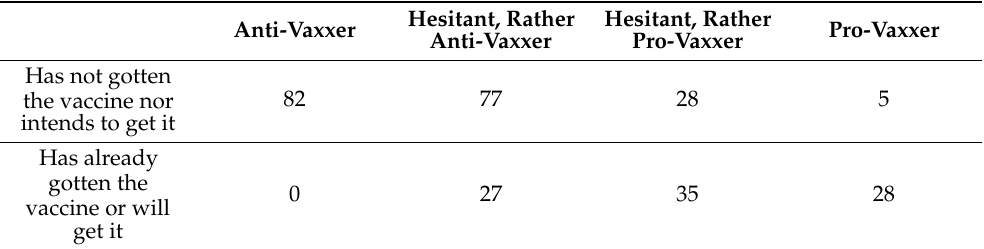
Table A2. Crosstabulation of the attitude towards the Piresian vaccine with the traditional objective measurement of vaccine hesitancy. Cell counts.